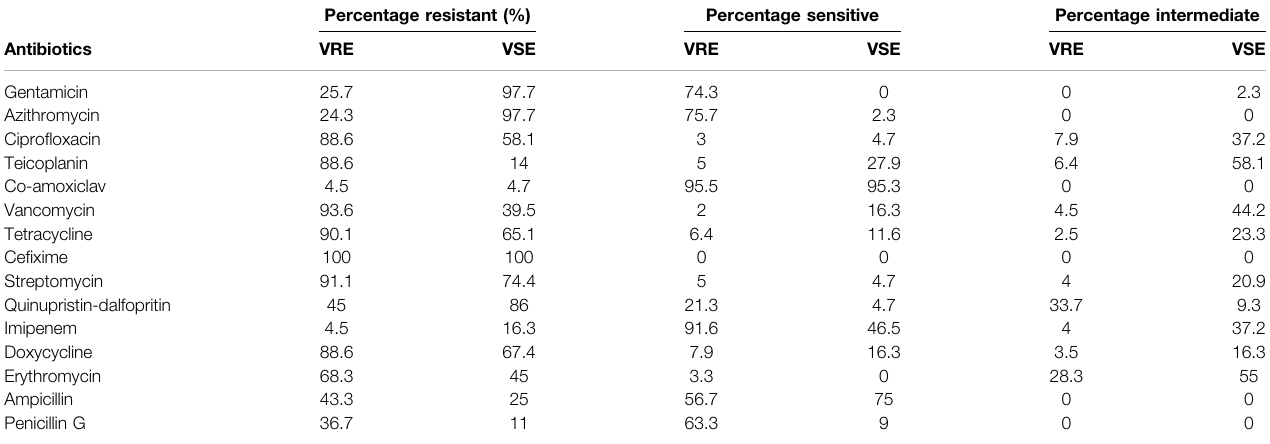
TABLE 5 | Antibiotic resistance pro fi le of the VRE and VSE